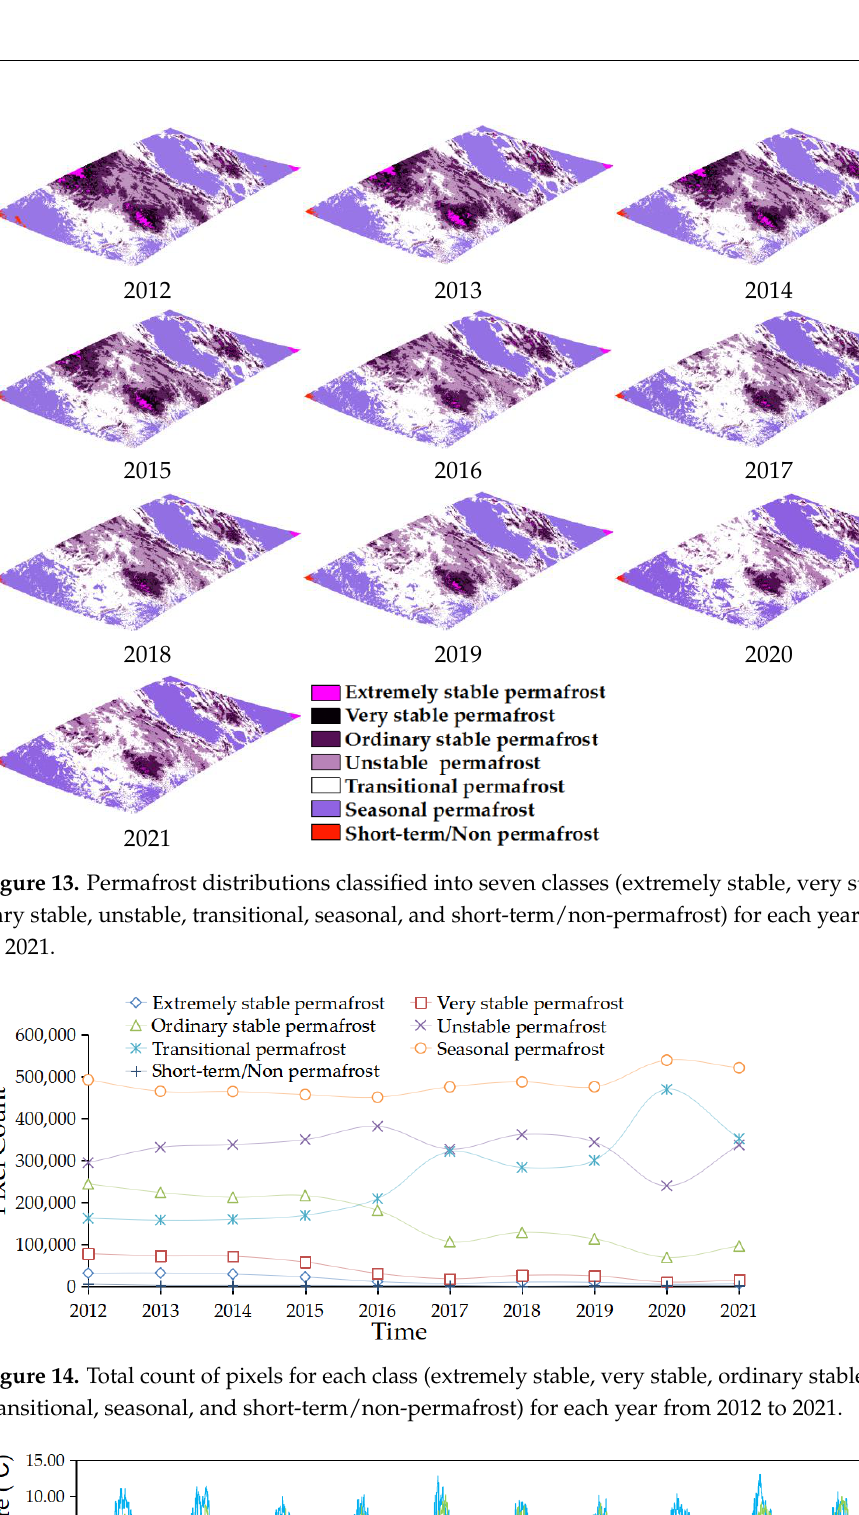
15 of 22 Figure 12. Temporal changes of the mean subsurface temperatures at the depths of 10, 20, 30, 40, 50 and 60 cm in 2012, obtained by the TLZ model. 3.2.4. Permafrost Classification Maps with Seven Classes Figure 13 shows permafrost distributions classified into seven classes (extremely stable, very stable, ordinary stable, unstable, transitional, seasonal, and short-term/non- permafrost), obtained by combining the TLZ model with the results of Figure 8. Figure 14 displays the total pixel count of each permafrost type as a function of time. From these figures, we can conclude the following. • Extremely and very stable classes slightly decreased during the study period. These decreases were mainly caused by changes from extremely to very stable classes, and